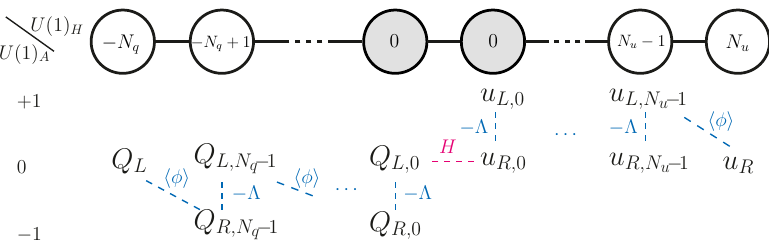
Figure 5 . The traditional FN chain with an additional axial U(1) A symmetry to prevent (cid:30) (cid:3) cross links. The horizontal charges are denoted in the nodes | the vector-like quarks on the two greyed out nodes, linked by the Higgs, do not carry a horizontal